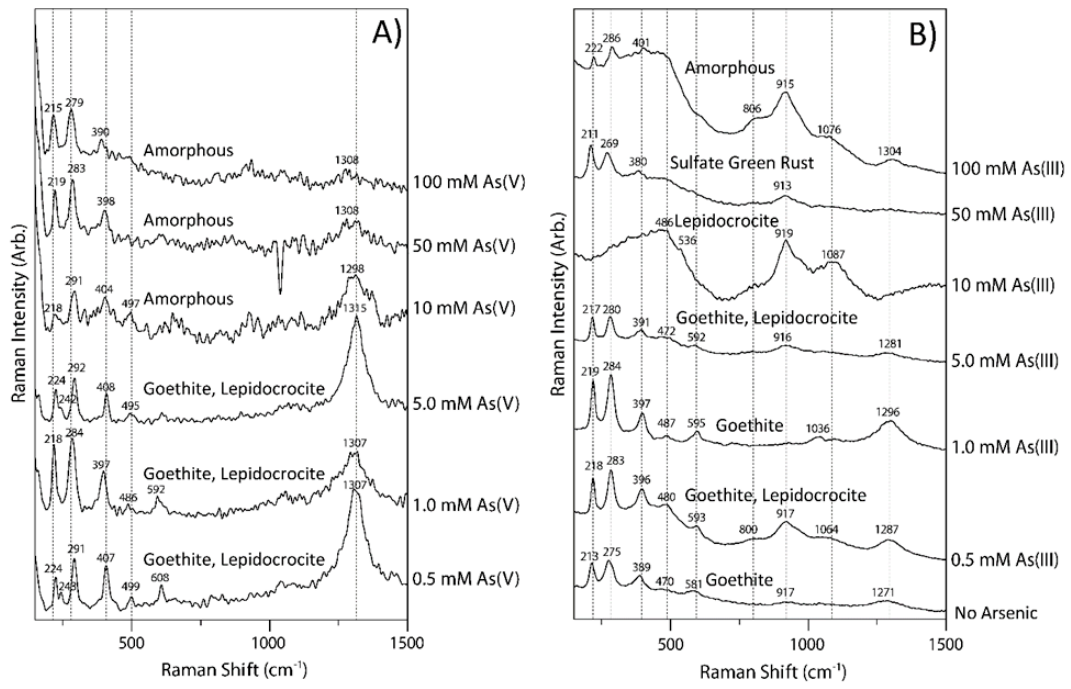
Figure 2. Raman spectra of coprecipitates formed at varying initial concentrations of dissolved As(V) ( A ) and As(III) ( B ).